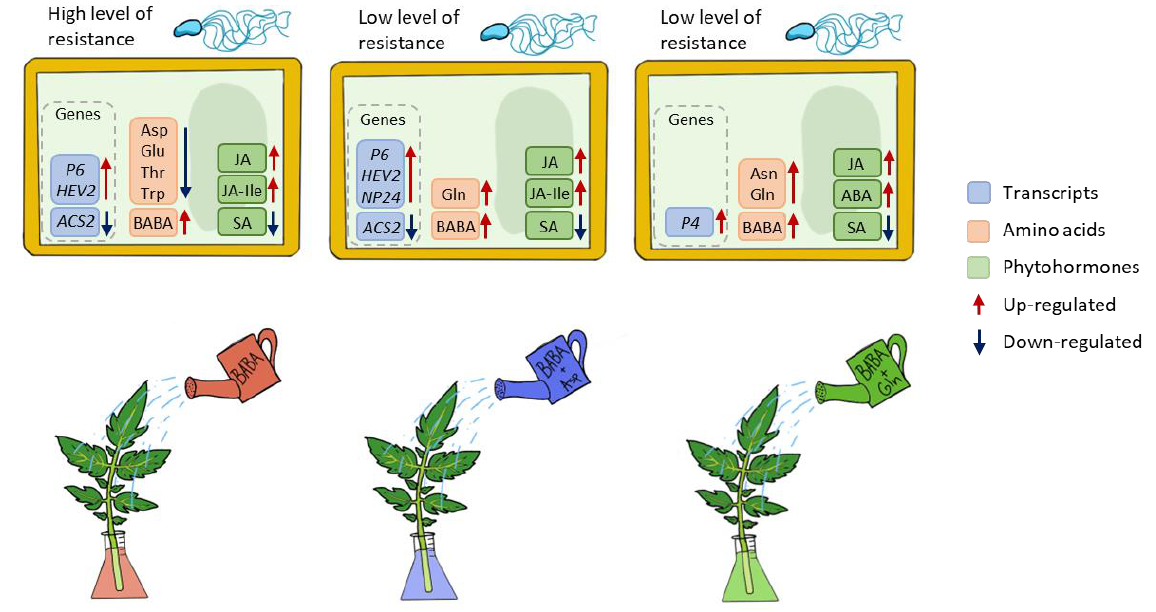
Figure 5. Schematic representation of processes operated in tomato plants after treatment with BABA or BABA + amino acids Asp and Gln.